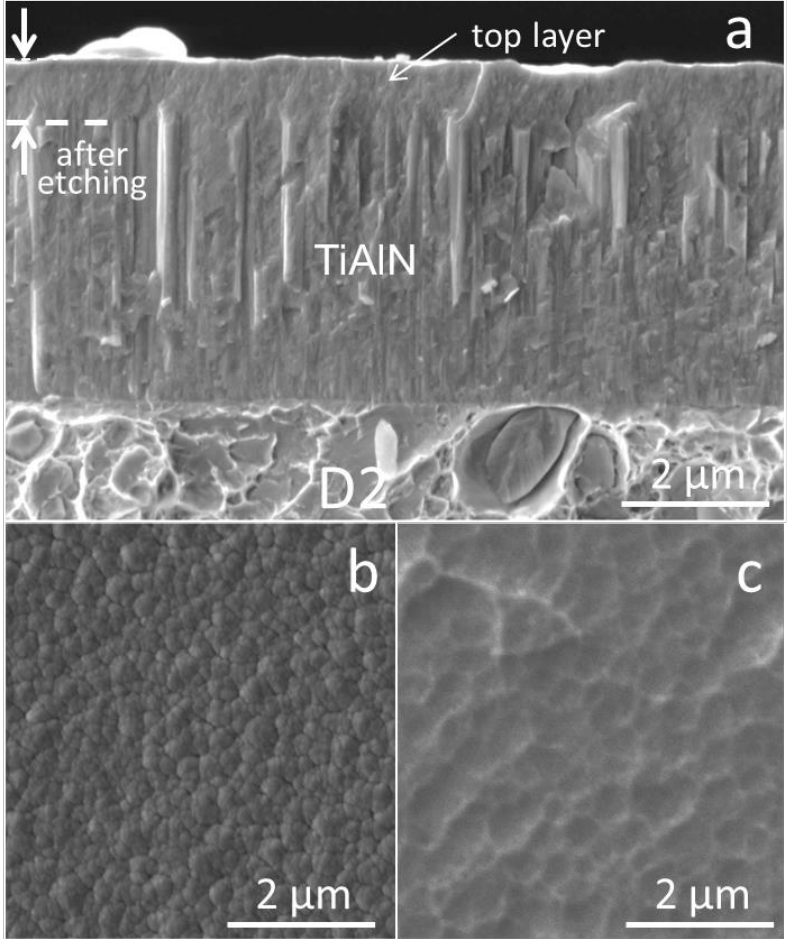
Figure 21. ( a ) Fracture cross-sectional SEM image of TiAlN coating sputter deposited in CC7 on D2 tool steel substrate; ( b ) top-view SEM image of the TiAlN coating prepared without ( b ) and with ( c ) an intermediate ion etching step.